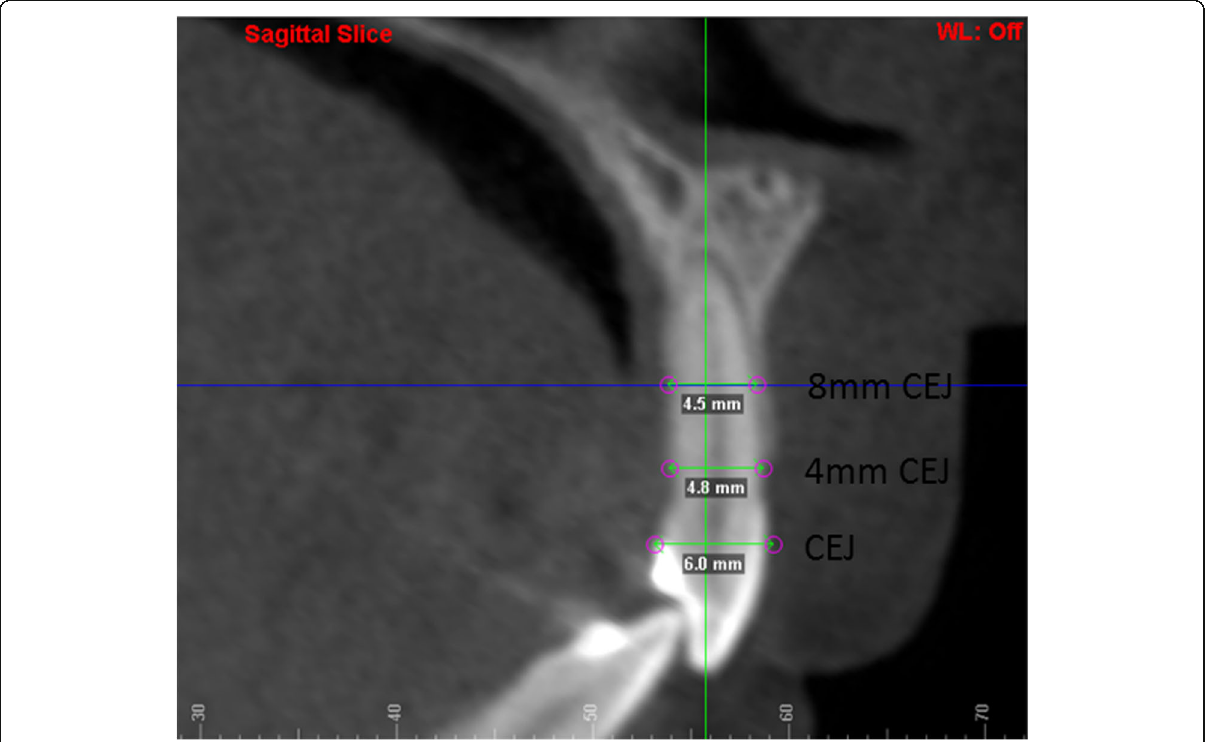
Fig. 3 Labiopalatal root width on sagittal section at the CEJ, 4 mm apical to CEJ and 8 mm apical to